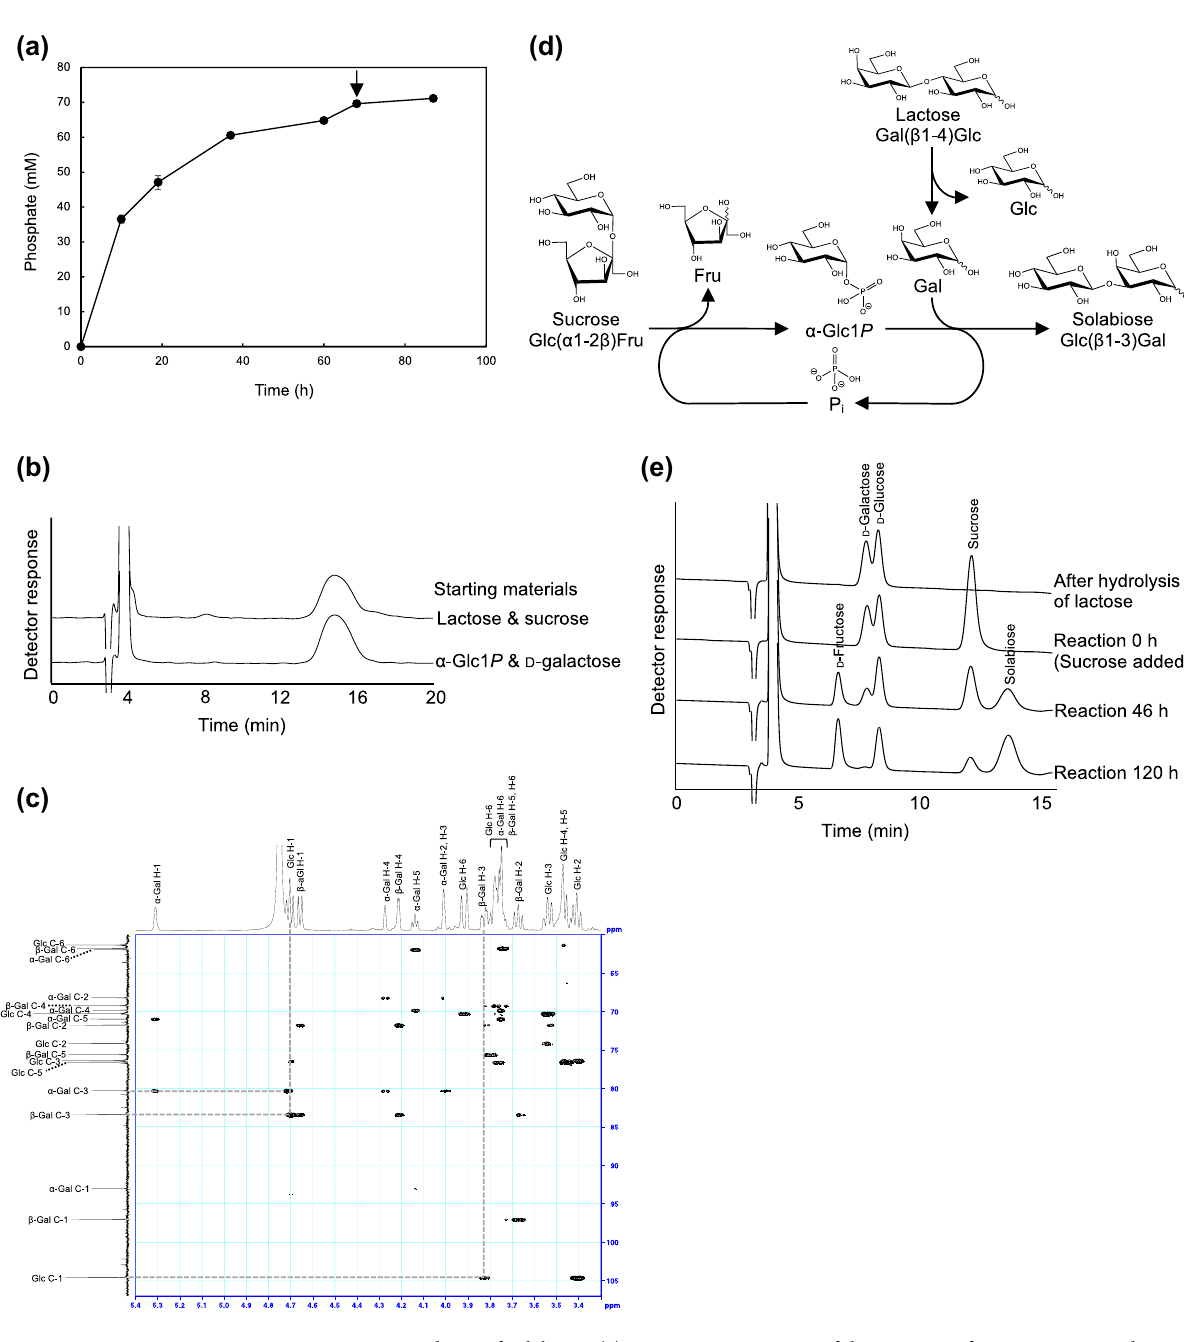
Figure 3. Enzymatic synthesis of solabiose. (a) Reaction time course of the reaction of PBOR_28850 with 100 mM α-Glc1 P and d-galactose. Arrow indicates the time of adding the additional enzyme. Values and error bars indicate average and standard deviation for three independent experiments, respectively. (b) HPLC elution profile of solabiose prepared from α-Glc1 P and d-galactose and from lactose and sucrose. (c) Heteronuclear multiple bond correlation spectroscopy analysis of solabiose produced from α-Glc1 P and d-galactose. Dotted line indicates correlation signals between β-d-glucosyl residue and d-galactose residue. (d) Reaction scheme of enzymatic synthesis of solabiose from lactose and sucrose. β-Galactosidase hydrolyzes lactose to d-galactose and d-glucose. SP phosphorolyzes sucrose to α-Glc1 P and d-fructose. α-Glc1 P and d-galactose are used in the reverse phosphorolysis catalyzed by PBOR_28850 to produce solabiose. Inorganic phosphate used in the phosphorolysis of sucrose is generated in the reverse phosphorolysis of solabiose. (e) HPLC elution profile of the reaction